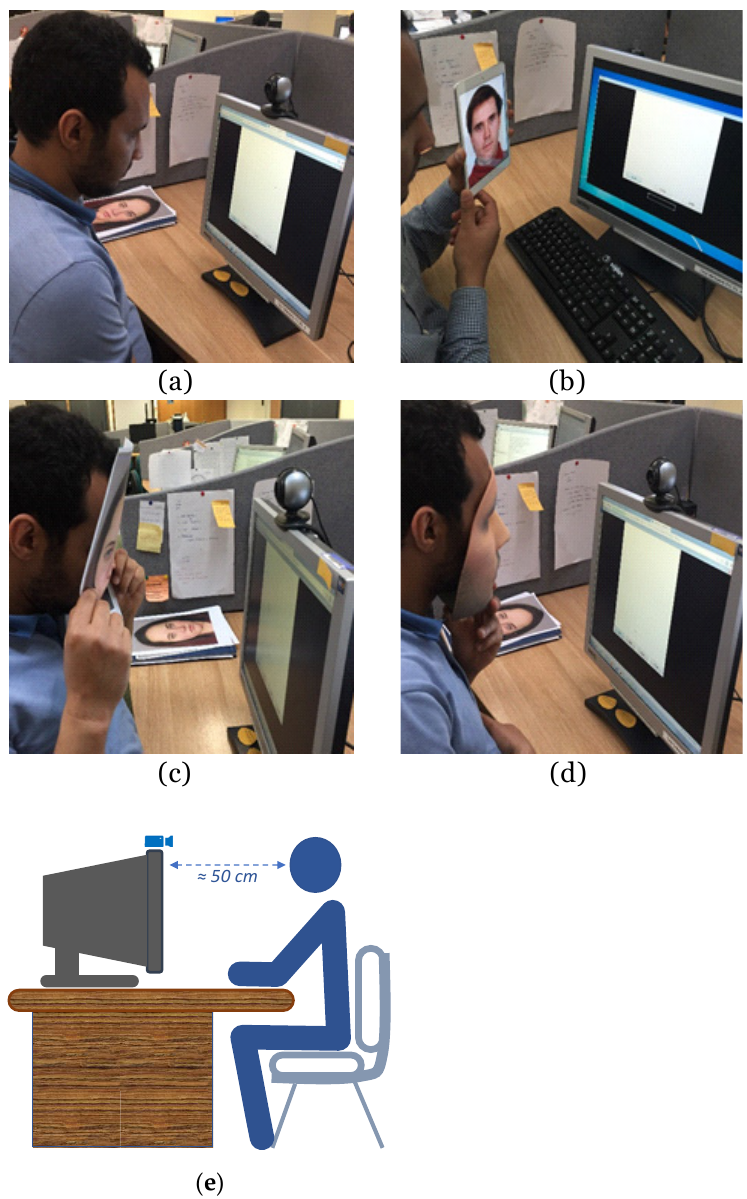
Figure 4. Data collection process: ( a ) genuine attempt; ( b ) photo attack; ( c ) 2D mask attack; ( d ) 3D mask attack; and ( e ) the setup used for data acquisition.